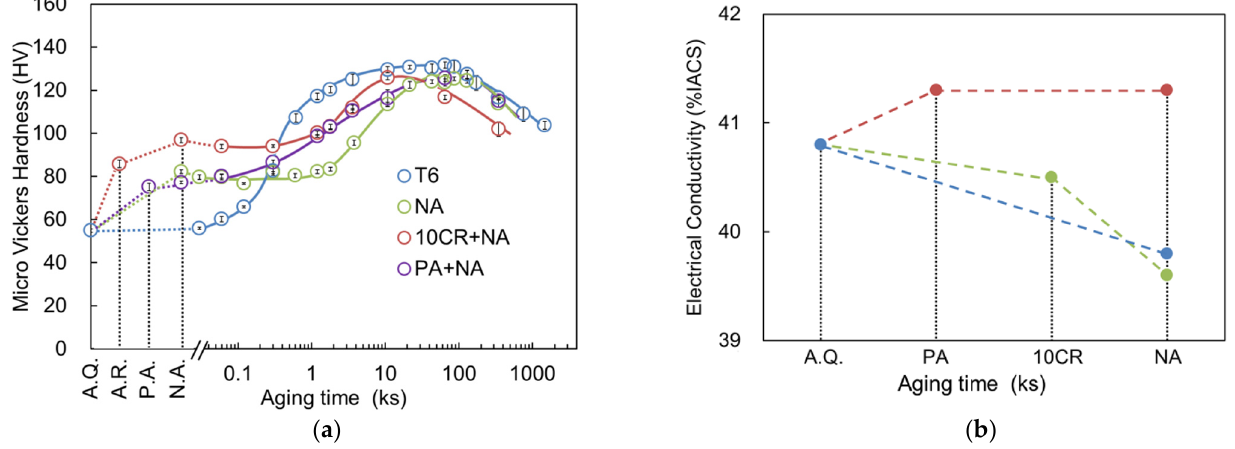
Figure 3. ( a ) Hardness change of T6, NA, 10CR + NA and PA + NA samples during artificial aging at 170 °C and ( b ) comparison of electrical conductivity after pre-aging, 10% cold rolling and natu- ral aging.